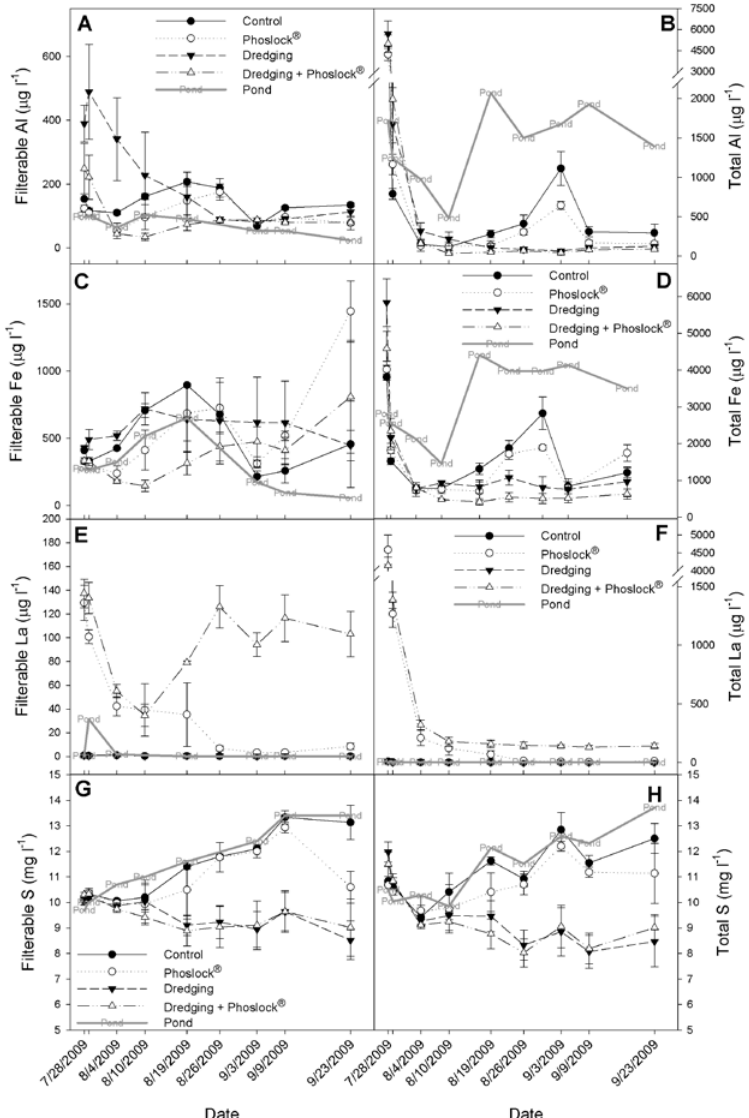
Figure 3. The course of filterable (Panel A ) and total aluminum concentrations (μg Al L − 1 ; Panel B ), filterable (Panel C ) and total iron concentrations (μg Fe L − 1 ; Panel D ), filterable- (Panel E ) and total lanthanum concentrations (μg La L − 1 ; Panel F ), and filterable- (Panel G ) and total sulfur concentrations (mg S L − 1 ; Panel H ) in control enclosures, LMB-treated enclosures, dredged enclosures, combination LMB-treated and dredged enclosures, and the pond over the 58-d experimental period in 2009. Error bars indicate one standard error ( n = 3).